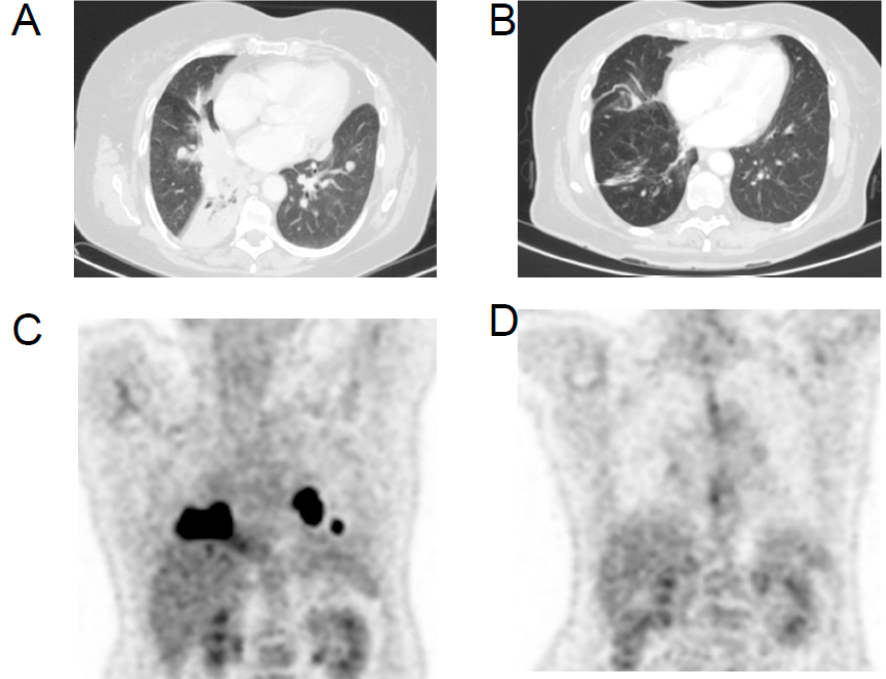
Figure 3. Axial CT image of lung ( A ) lesion before the start of combined lenvatinib/pembrolizumab treatment and ( B ) after 18 months of treatment; representative 18FDG-PET/CT images ( C ) at the initiation of the combined lenvatinib/pembrolizumab treatment and ( D ) after 18 months of